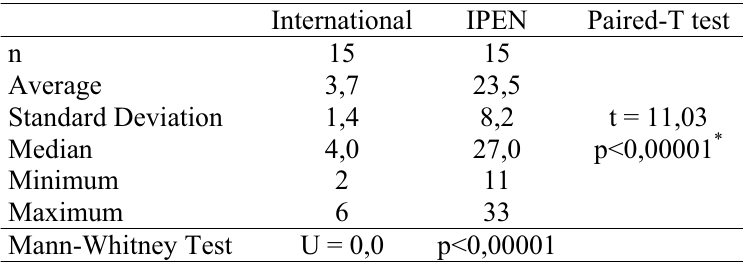
TABLE 2 – Comparison between the values of radiation reading in the back- ground of injection by using the International and the IPEN